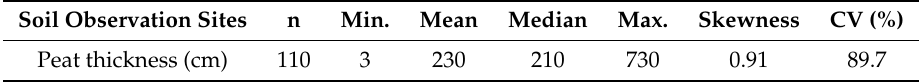
Figure 4. Peat thickness (cm) measured at soil observation points and locations of cross-sections S1 and S2. Table 2. Summary statistics for peat thickness at the soil observation sites.